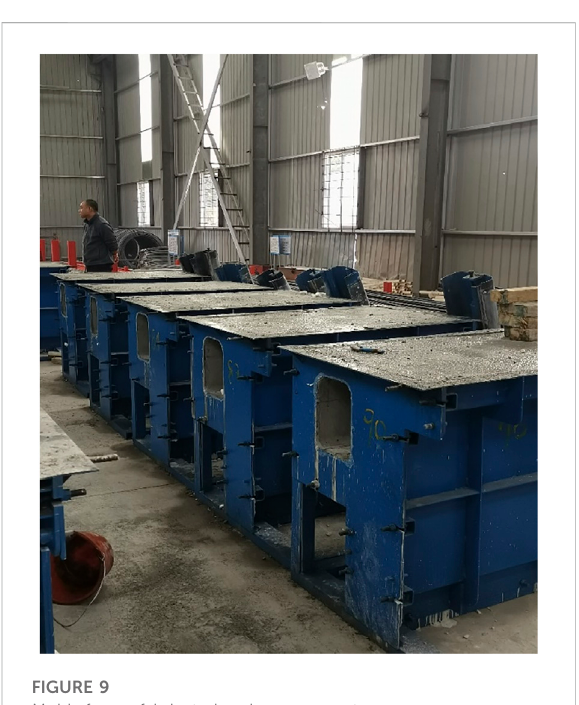
FIGURE 9 Molds for prefabricated curb components.